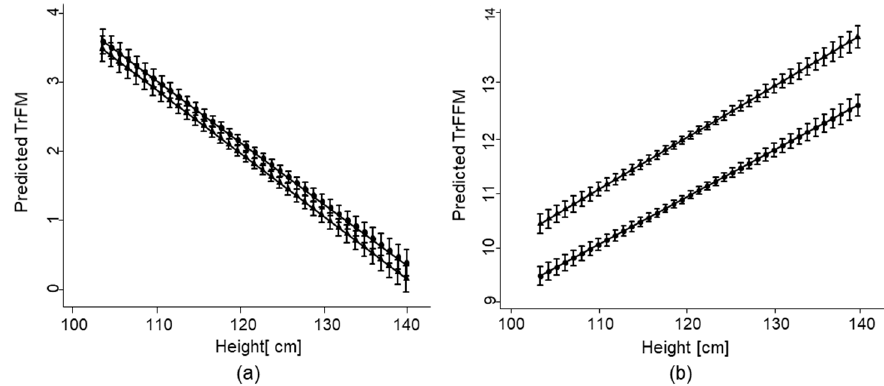
Figure 3. Association of height with body composition estimates by sex of school-aged children in the South African arm of the KaziAfya project: ( a ) TrFM; ( b ) TrFFM. Boy ; girl .